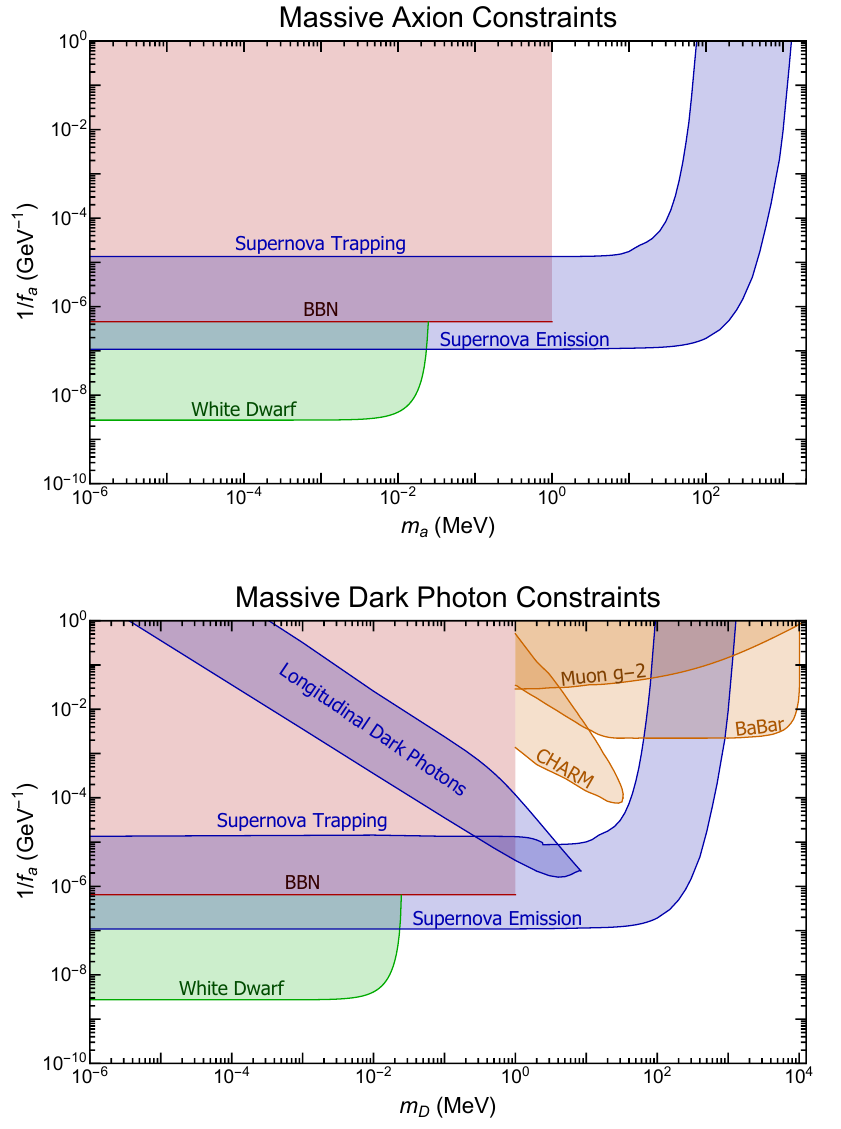
Figure 8 . The constrained regions on the coupling 1 /f a from the various astrophysical and collider sources. The first plot corresponds to a massive axion and a massless dark photon while the second plot corresponds to a massive dark photon and a massless axion. The blue constraint are those due to the supernova constraints examined in section 2, section 3 and section 4. The green constraint is due to white dwarf cooling constraints examined in section 5. The red constraint is a very conservative BBN constraint computed in section 5. The orange constraints are the various collider constraints taken from ref. [59]. Note that these constraints are only shown in the massive dark photon plot since ref. [59] only considers the m D (cid:29) m a limit. Similar collider constraints exist for the opposite limit but have not yet been computed. Also note that slightly stronger bounds than the white dwarf cooling bounds can be obtained by using the recent analysis of the tip of the red giant branch [40,